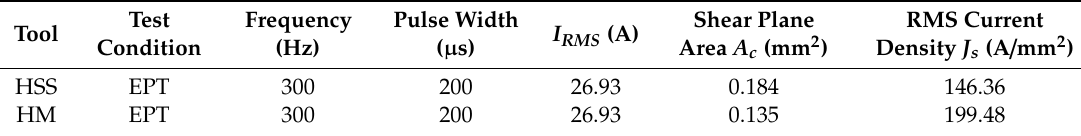
Table 4. Electropulsing parameters during the metal-cutting